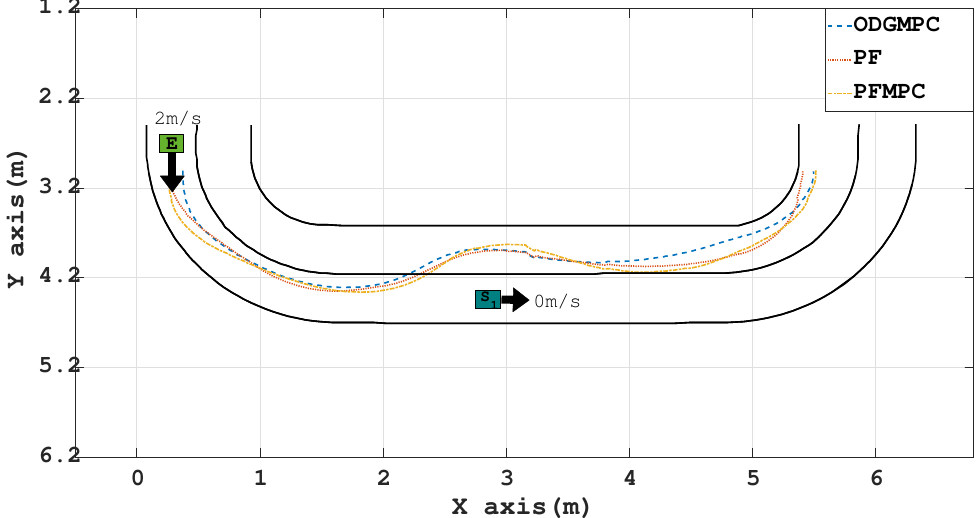
Figure 19. Results of the path from Scenario 2 for a static